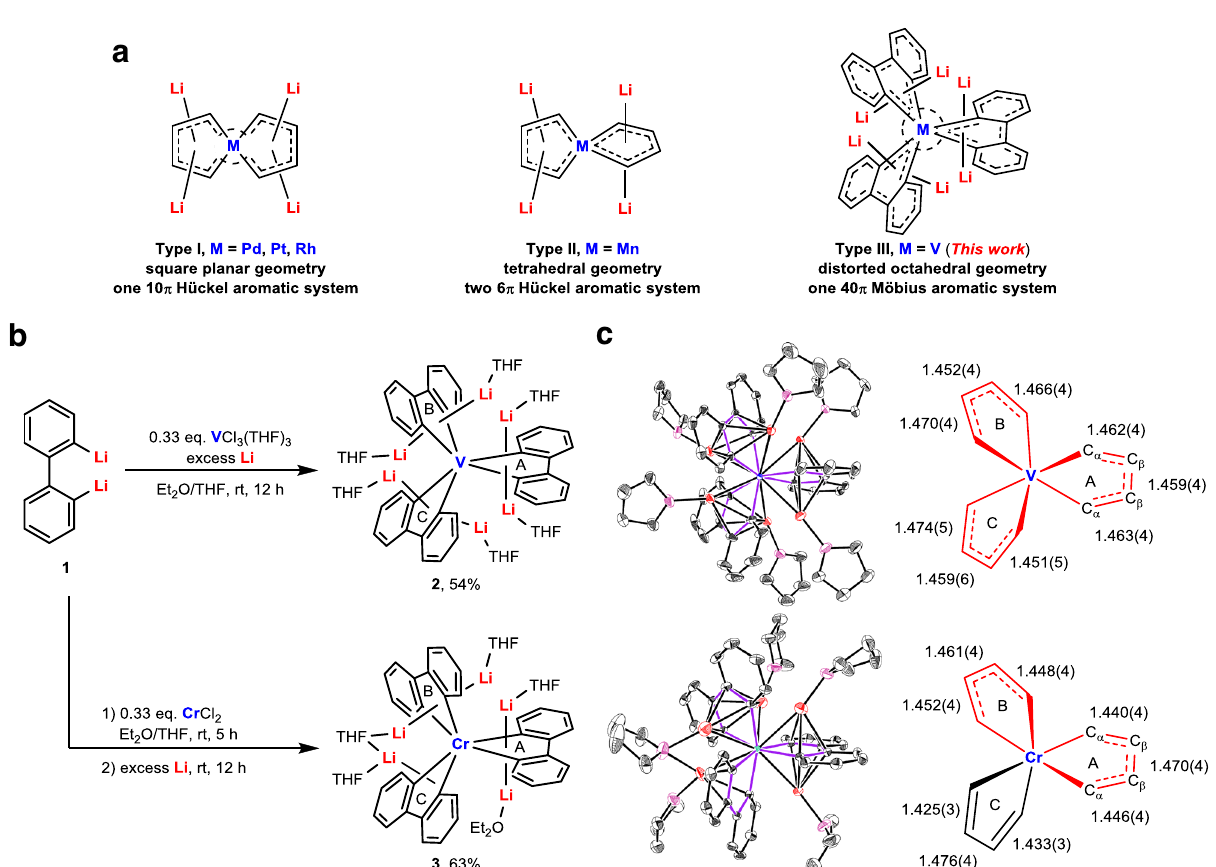
Fig. 1 Synthesis and molecular structures of hexalithio spiro vanadacycle 2 and pentalithio spiro chromacycle 3. a , Three types of spiro metalla- aromatics. b , Synthesis of complexes 2 and 3 . c , X-ray molecular structures of complexes 2 and 3 drawn with 30% thermal ellipsoids and selected bond lengths (Å). Hydrogen atoms are omitted for clarity. Metalla-aromatic rings are drawn in